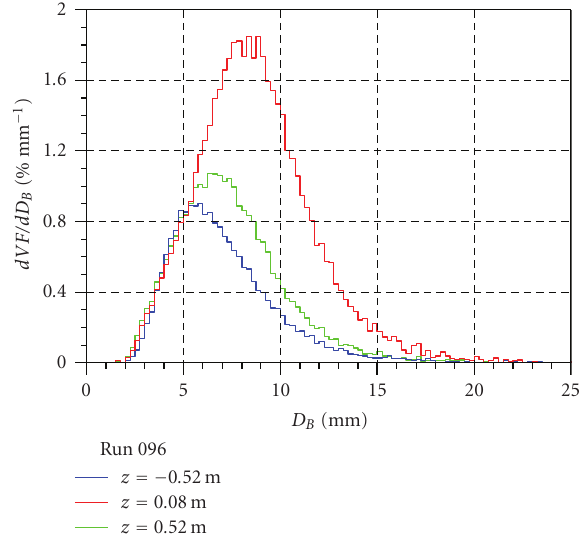
Figure 7: Measured bubble size distribution for run 096.